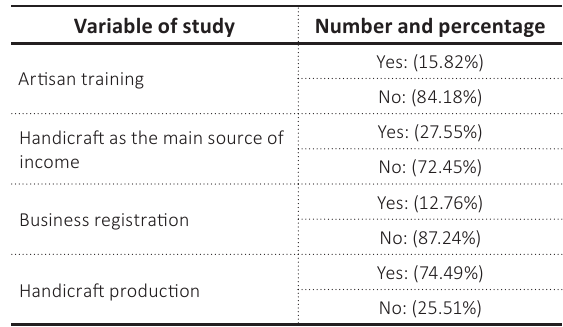
Table 3. Summary of percentages of artisan